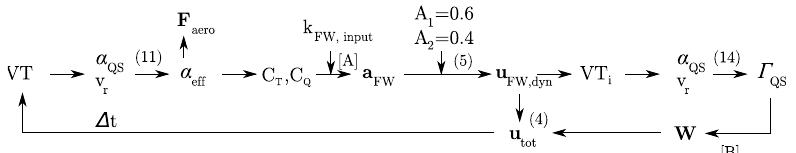
Figure 1. The previous implementation of the coupled near- and far-wake model, as described by Madsen and Rasmussen (2004) and Andersen (2010). The numbers in parentheses refer to the equations in the following sections, [B] to the original model by Beddoes (1987), and [A] to Andersen (2010). The vector notation on the induction factors and induced velocity indicates that the model can be used to compute both axial and tangential